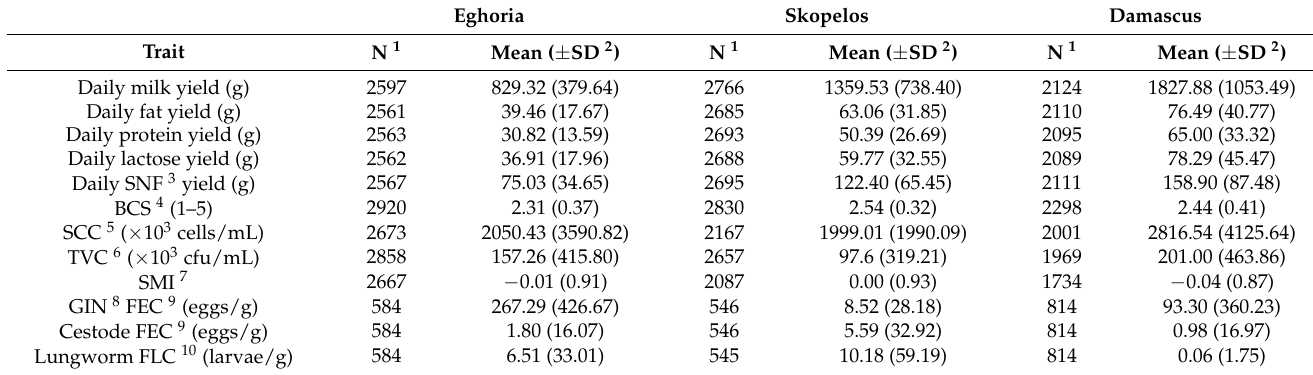
Table 1. Descriptive statistics of milk production, body condition score, udder health (SCC, TVC, SMI) and parasitism (faecal egg and larval counts) traits in the studied goat breeds. Eghoria Skopelos